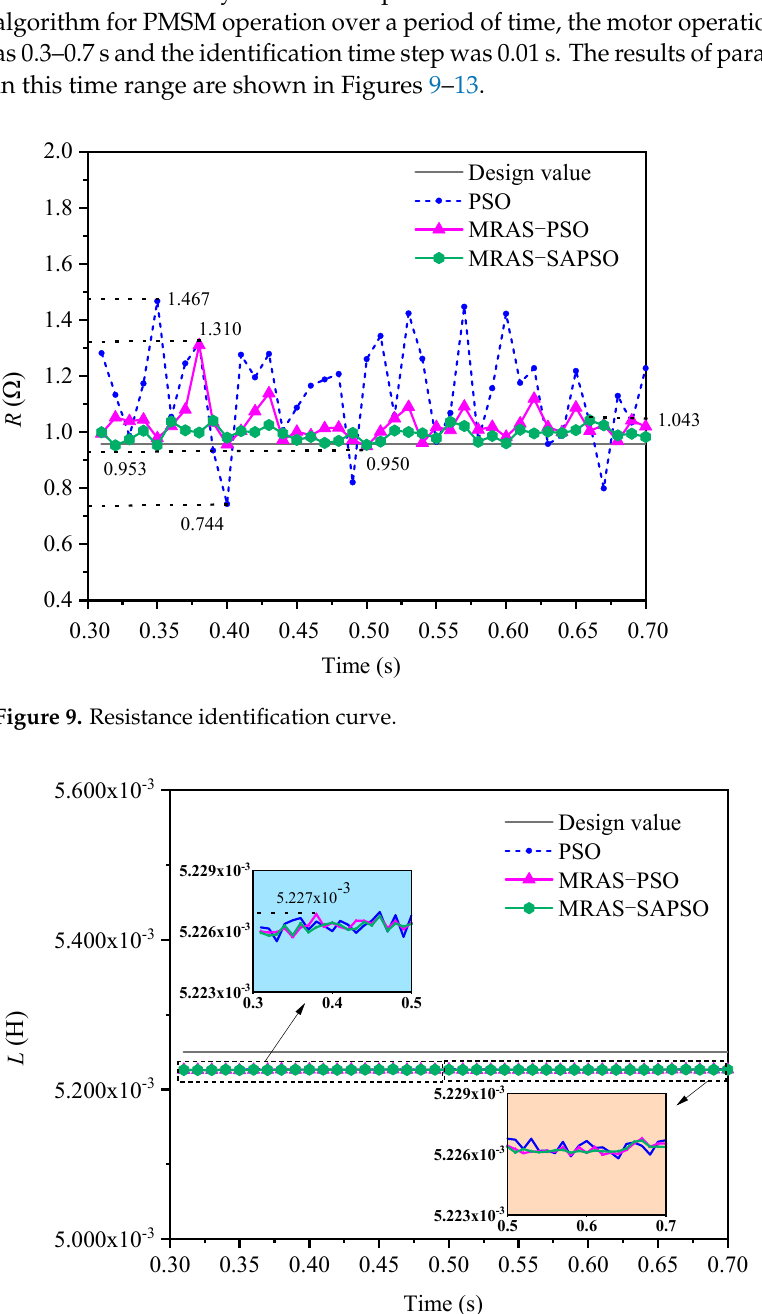
Figure 10. Inductance identification curve.